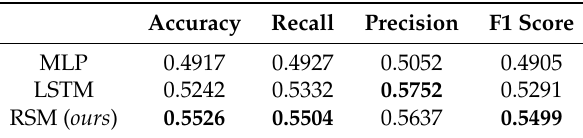
Table 6. Universal patterns (LTCUSD). Model evaluation scores use the same metric as in Table 1. We evaluated the same baselines and our model on a different dataset from the dataset on which they were trained. Lite Coin US dollar (LTCUSD) in the OkCoin market was used as the evaluation dataset. We used the parameters optimized on